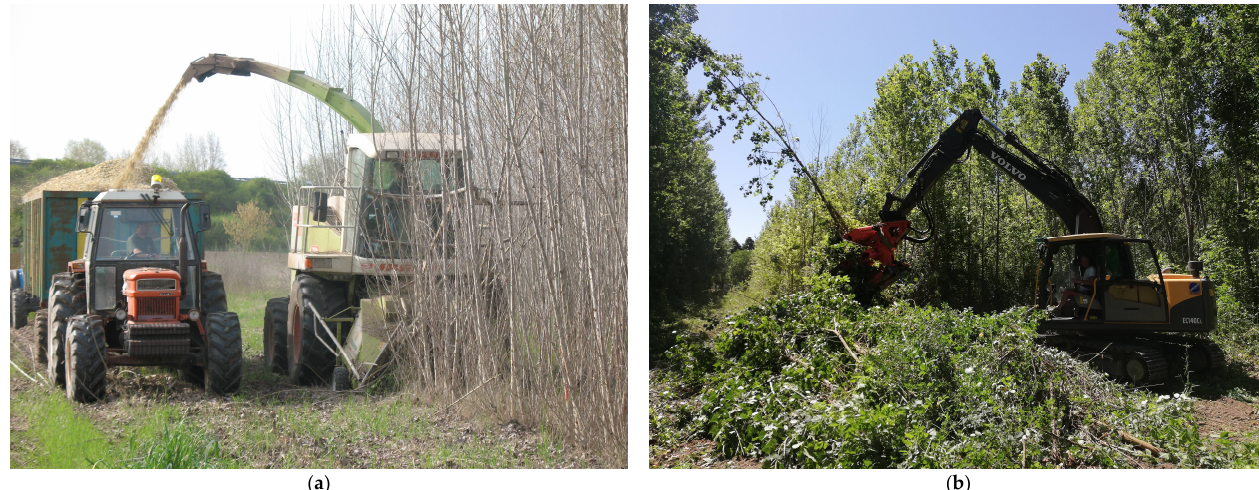
Figure 1. Mechanized harvesting systems on poplar rotation coppice plantations: ( a ) Forage-Based Harvesting System (FBHS); ( b ) Shear head-Based Harvesting System (SBHS).